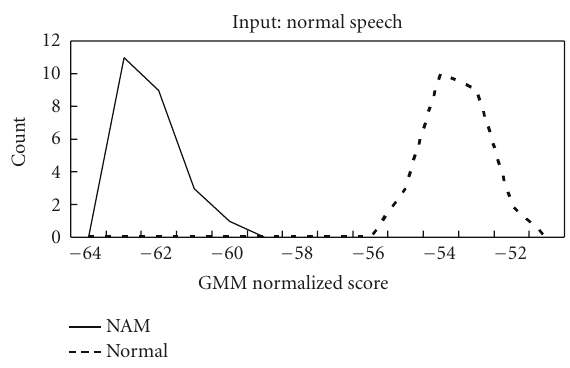
Figure 19: F0 contour of normal speech—close-talking micro- phone.